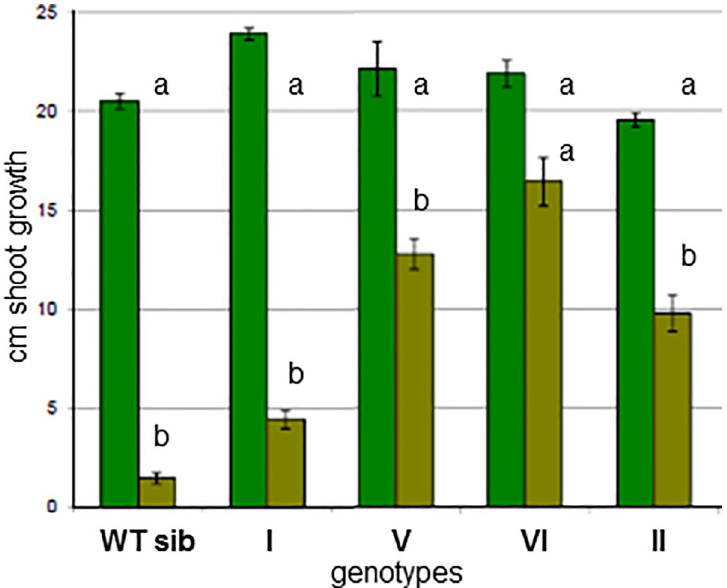
Fig 4. Shoot growth of different genotypes on Phytagel medium lacking or containing glyphosate. Average shoot height after twelve days is shown. Dark green bars represent medium without glyphosate. Light green bars indicate medium with 0.15mM glyphosate incorporated. Average +/- SE of six biological replicates is shown. Legend: WT sib: a wild type sibling line of a triple mutant line (genotype II in Fig 3B). I represents a double mutant line (genotype I in Fig 3B). V represents a line containing TIPS mutations on chromosome 7A and T 102 I mutations on both 4A and 7D chromosomes (genotype V in Fig 3B). VI has the TIPS mutation on chromosome 7D and P 106 S on the 7A chromosome as well as the T 102 I mutation on chromosome 4A (genotype VI in Fig 3B). II represents a genotype containing three single mutations (genotype II in Fig 3B). Different letters indicate significant differences between the genotypes and